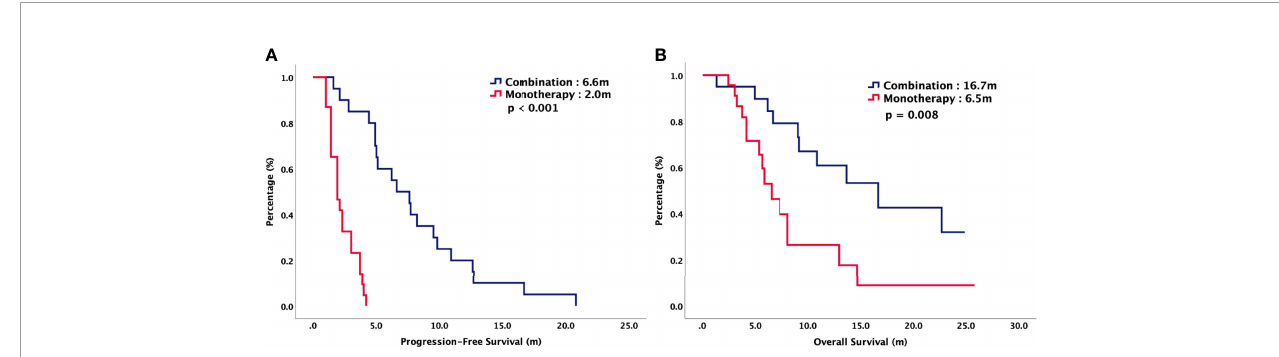
FIGURE 2 | (A) Progression-free survival and (B) overall survival of patients with chemorefractory mCRC treated with TAS-102, strati fi ed by combination or monotherapy.